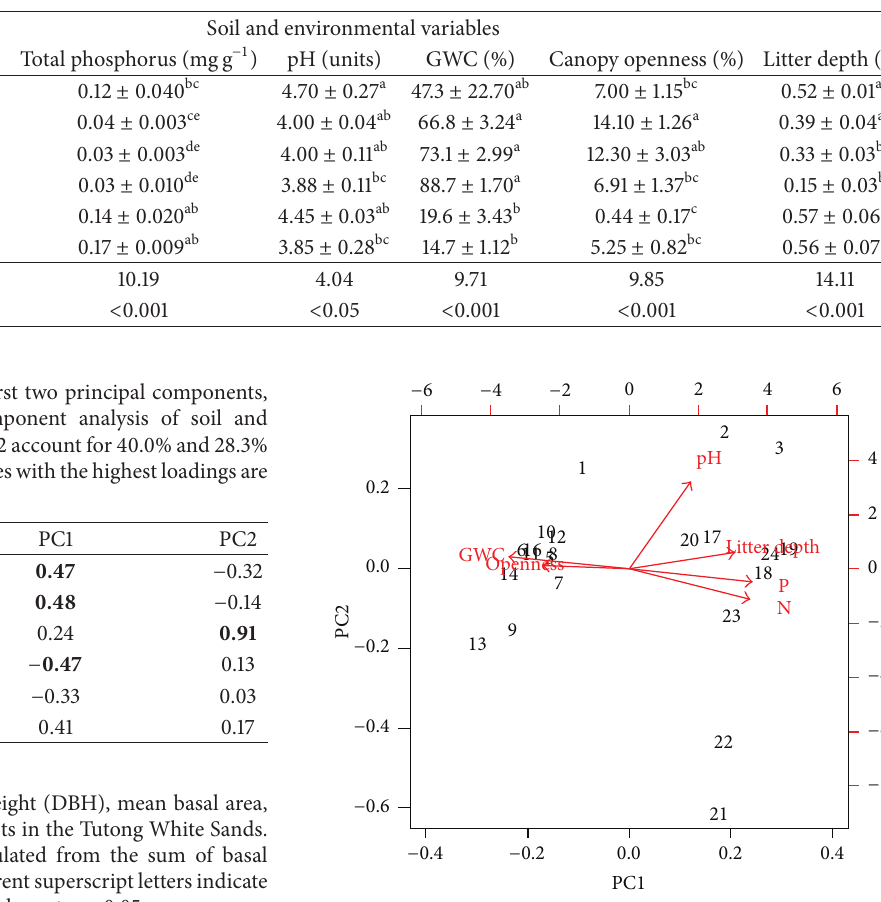
Table 1: Soil and environmental variables (mean ± SE) in six plots in the Tutong White Sands. 𝐹 and 𝑃 values from one-way ANOVA are shown for each variable. Different superscript letters within a column indicate significant differences at 𝛼 = 0.05.